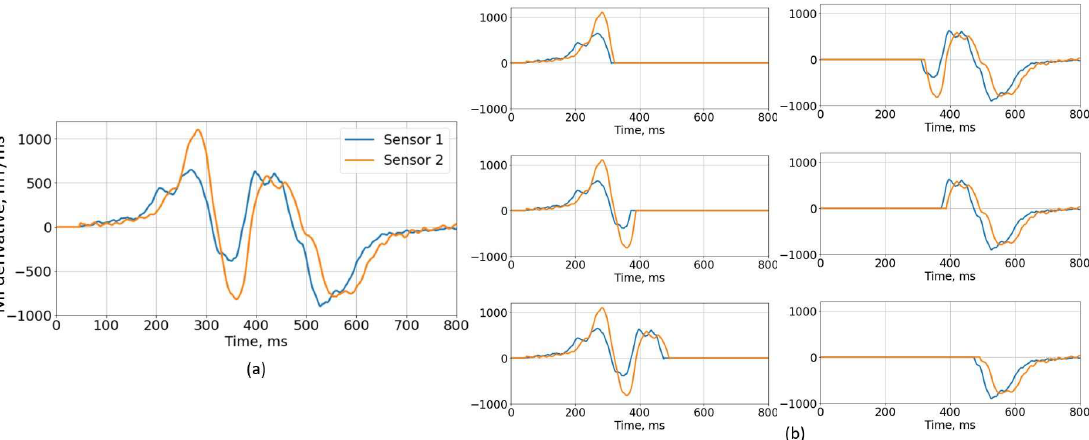
Figure 8. Signals segmentation algorithm example. ( a ) The first order derivative of the signatures is divided into 6 sub-signal pairs ( b ).